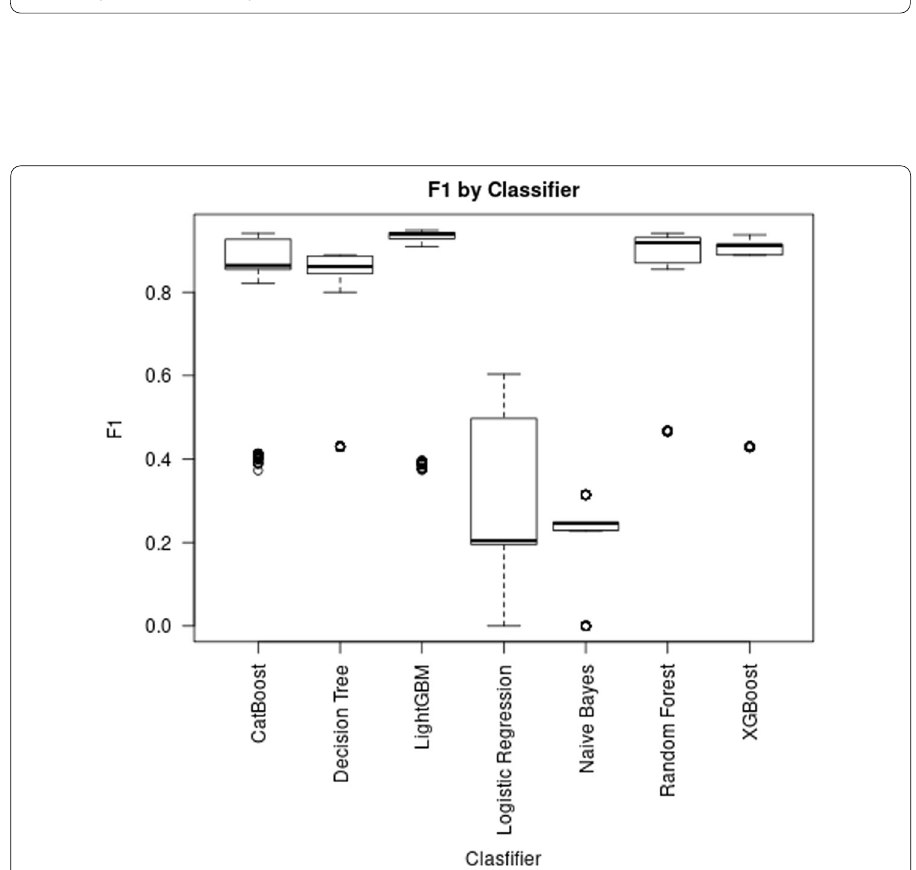
Fig. 3 Box plots of F1-score grouped by classifier; here datasets do not include destination port; Tukey’s HSD test indicates LightGBM, Random Forest, XGBoost in group a, CatBoost and Decision Tree in group b, Logistic Regression in group c, Naive Bayes in group